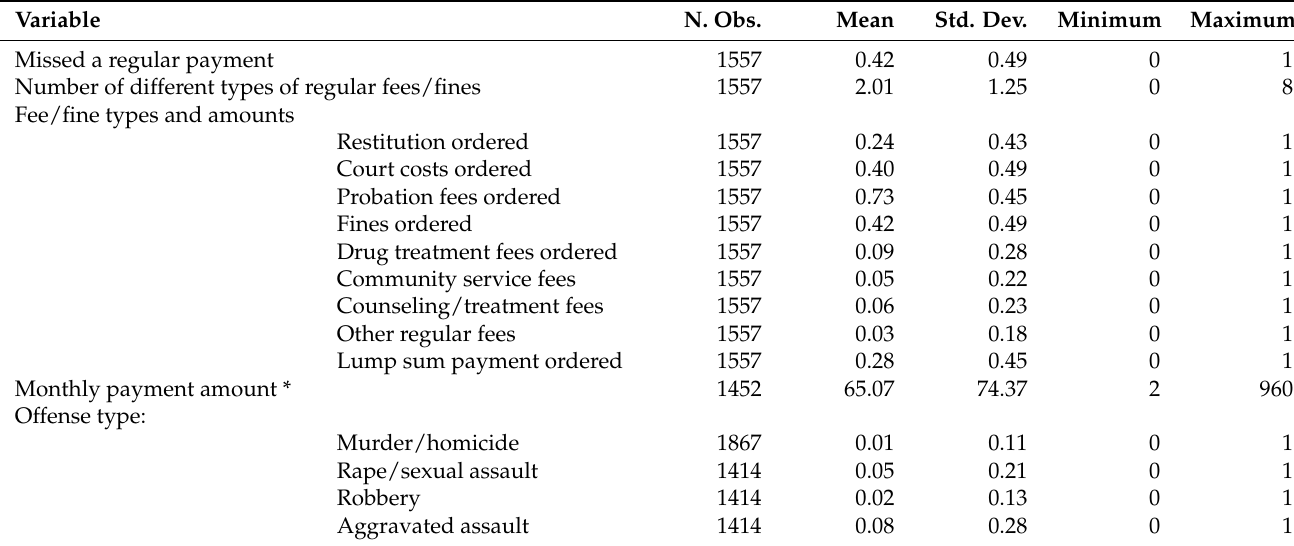
Table 1. Summary statistics on variables used in the analysis for the sample of persons on probation who were ordered to make at least one type of regular fee/fine